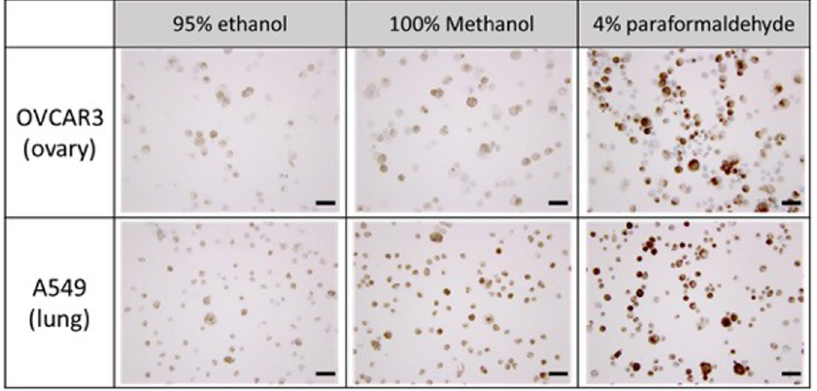
Figure 3. The immunocytochemical staining of cytokeratin for ovarian and lung cancer cells (OVCAR3, A549) fixed with 3 different fixative solutions (Scale bar = 50 μ m).